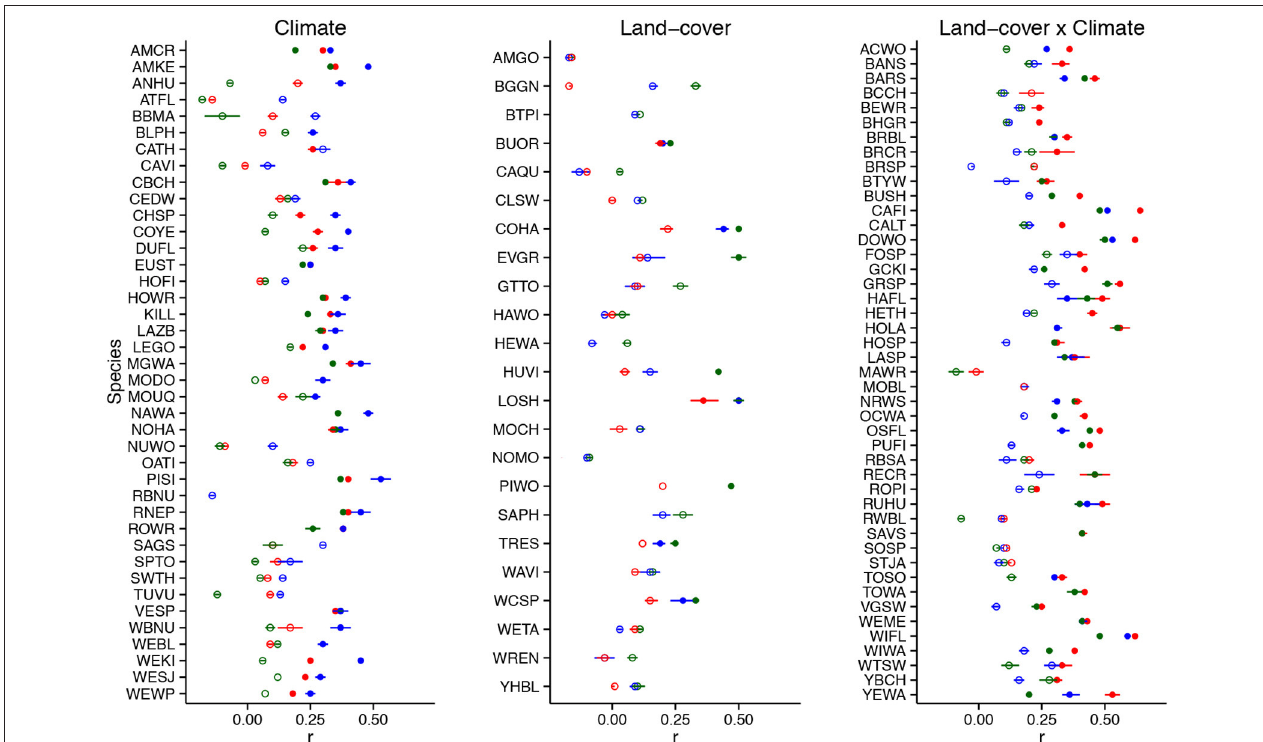
FIGURE 3 | Spearman correlations ( ρ1 ; here ’r’ ) for relationship between predicted and observed abundance changes for 108 terrestrial bird species of the western U.S. (1980–2010). Predictions were derived from boosted regression tree models using either Climate data, Land-cover data or both (Land-cover x Climate). Solid and open circles represent statistically significant ( α = 0.05) vs. non-significant correlations, respectively. Each species is only depicted only for the change element (climate, land-cover, land-cover x climate) that best predicted abundance change. See Table S3 for English and scientific names. Bars reflect 95% confidence intervals from 1000 model